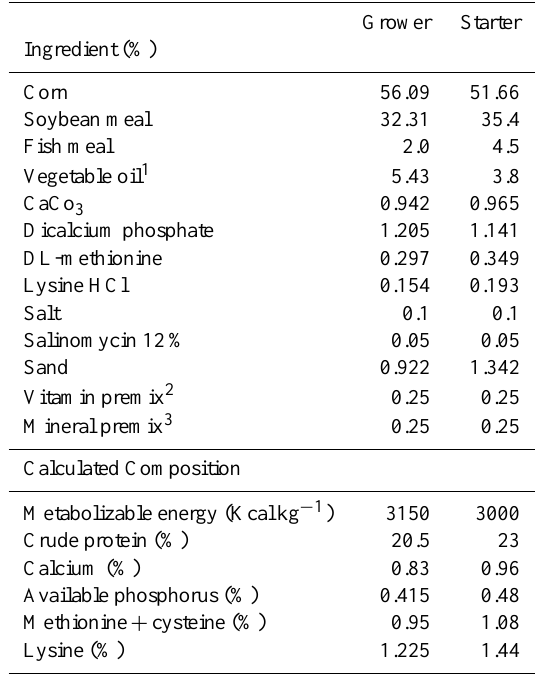
Table 1. The ingredient and calculated composition of basal diets at starter (1–15 days) and grower (15–35 days)